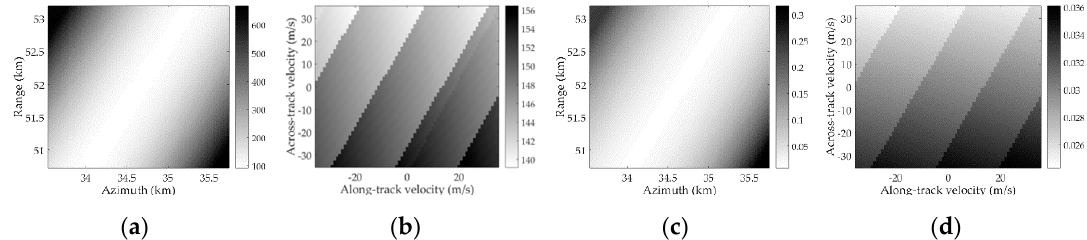
Figure 10. Effects of the µ 3 and µ 4 terms on phase errors with small acceleration. The unit of the contour maps is π /4: ( a ) phase error of the µ 3 term with different target locations; ( b ) phase error of the µ 3 term with different target velocities; ( c ) phase error of the µ 4 term with different target locations; and ( d ) phase error of the µ 4 term with different target velocities.